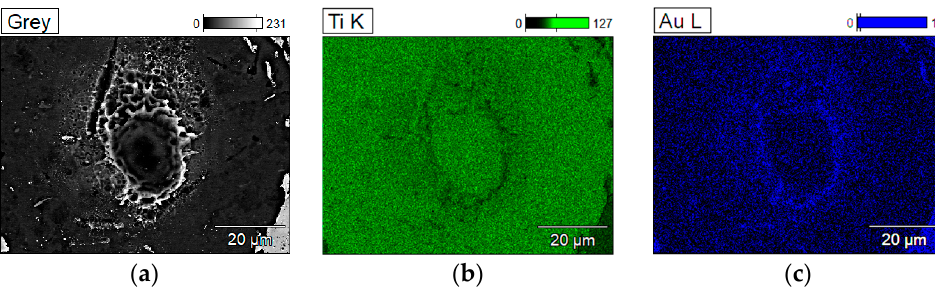
Figure 10. EDS qualitative chemical elements distribution map: ( a ) SEM image; ( b ) EDS spectrum map of Ti; ( c ) EDS spectrum map of Au.